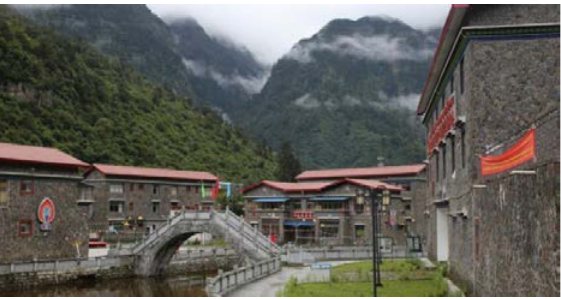
Figure 6. Town supported by the policy to develop rural tourism, Mamamenba, NRTTC.